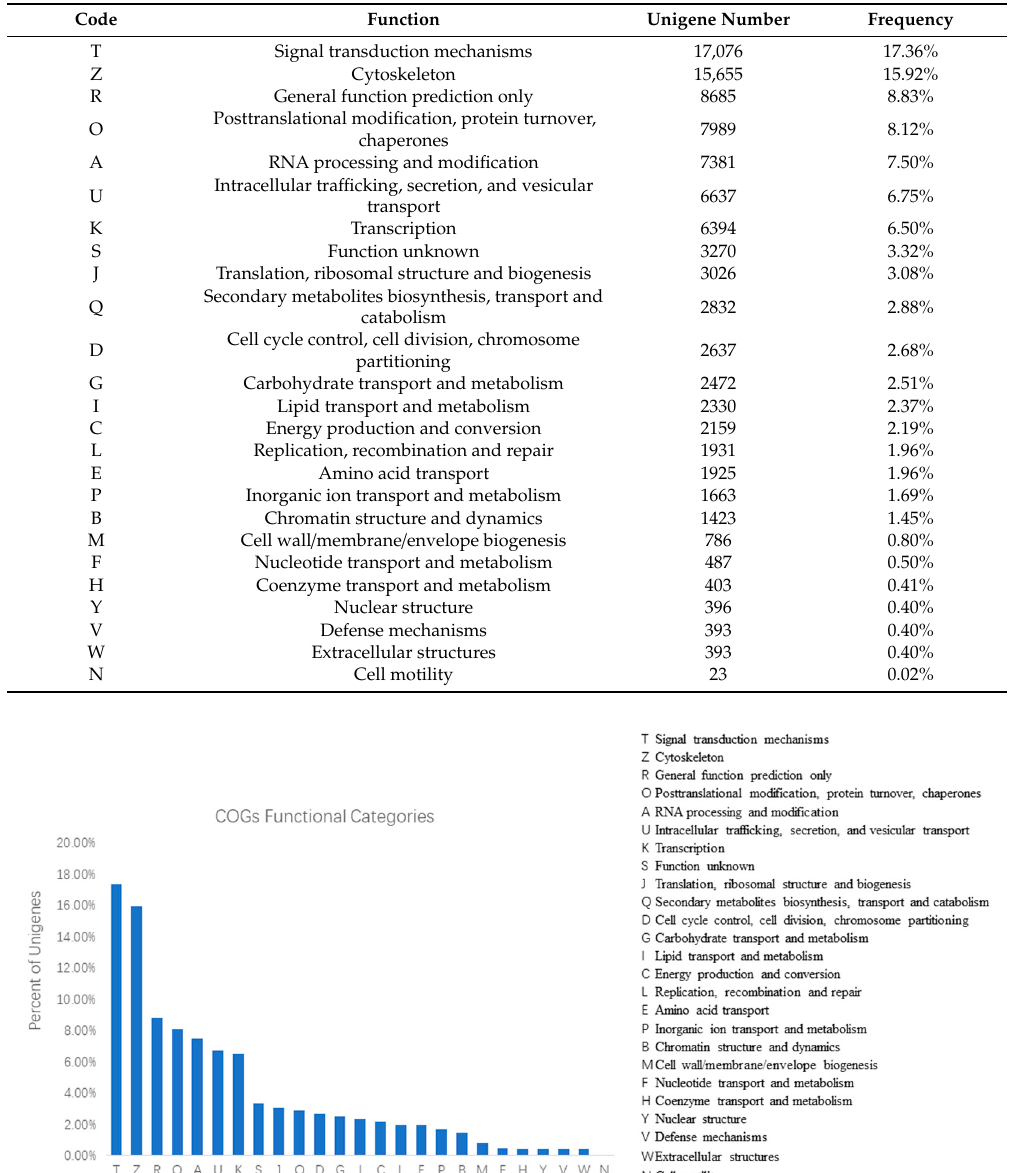
Table 4. Classification of COG.